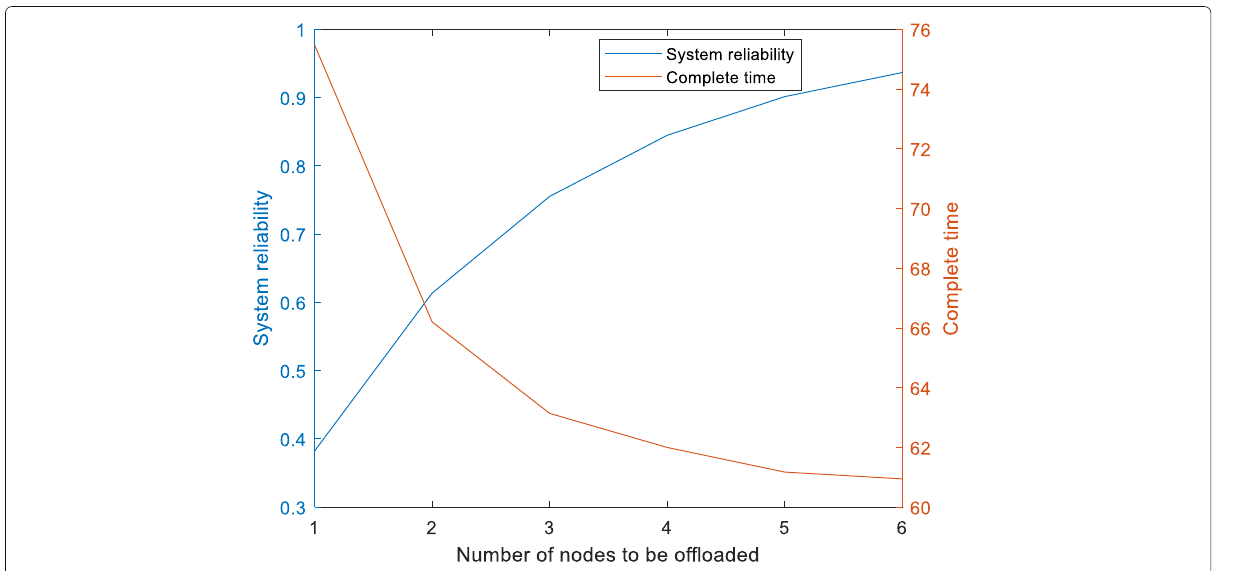
Fig. 9 Resource utilization and complete time comparison